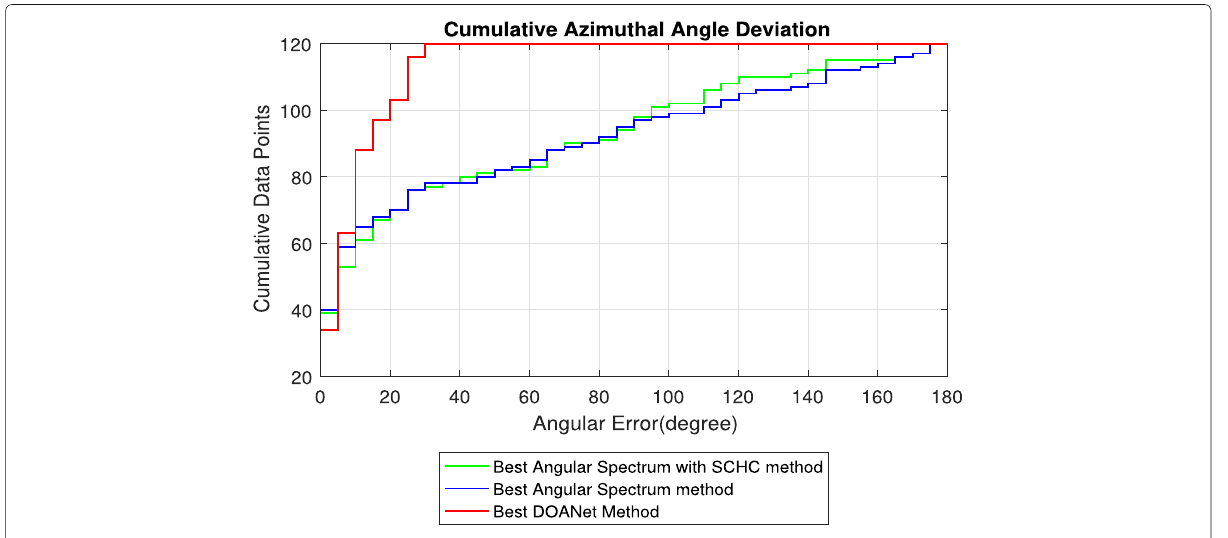
Fig. 8 AUCs for cumulative static azimuth angle deviation